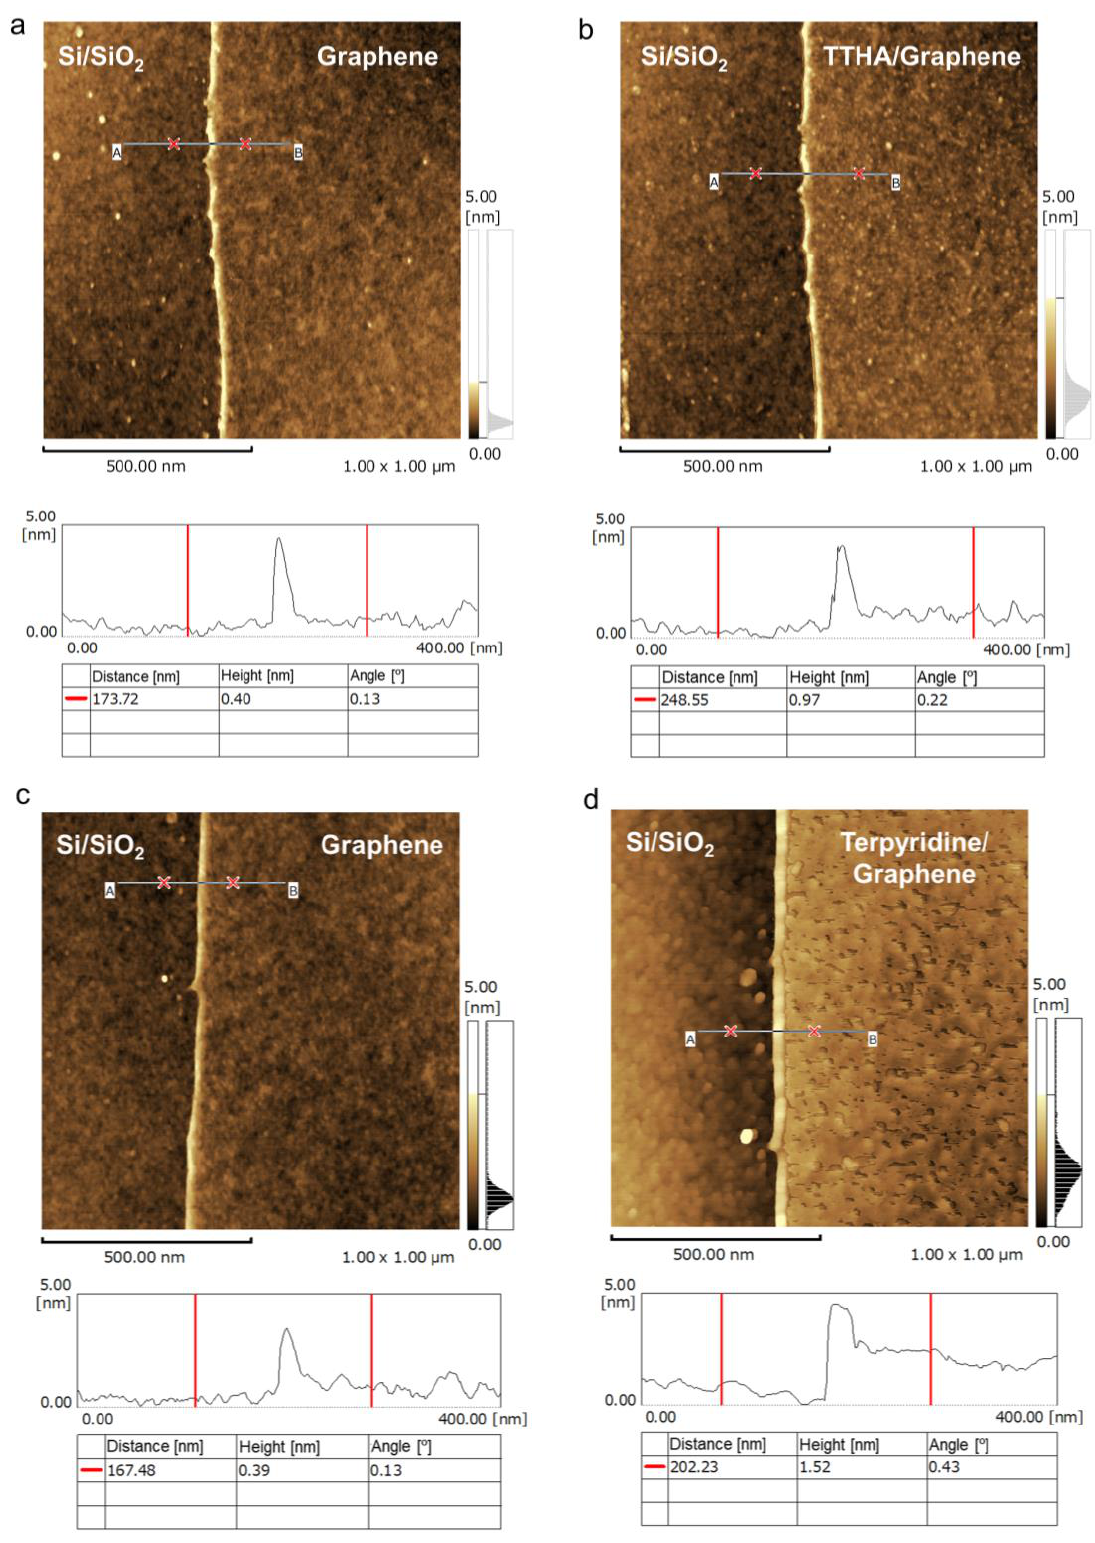
Figure 4. AFM images of ( a , c ) pristine graphene and graphene after being modified by ( b ) TTHA and ( d ) terpyridine.